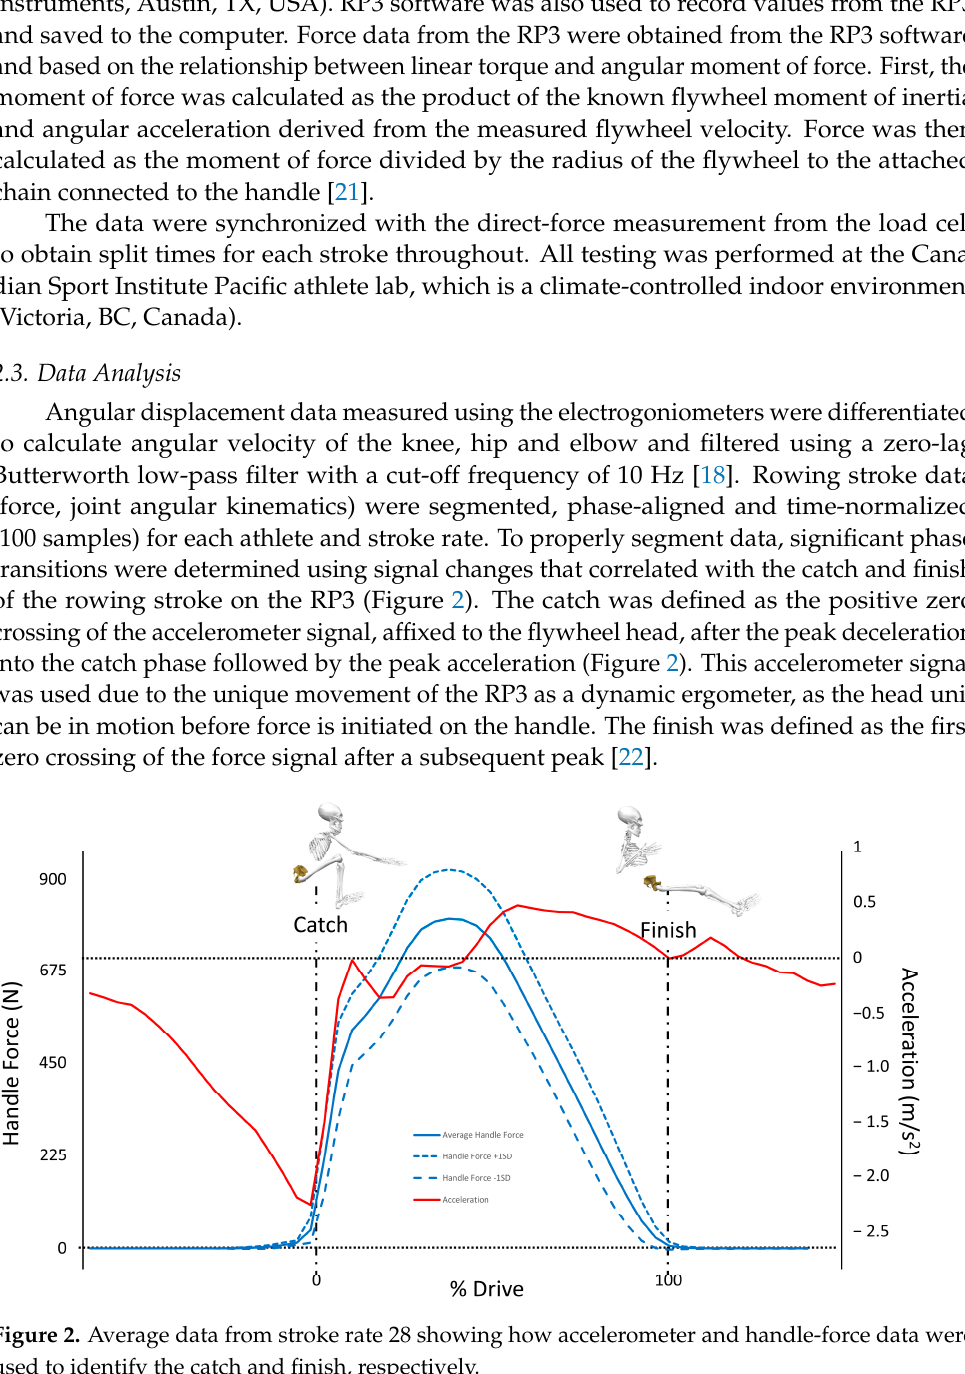
Figure 2. Average data from stroke rate 28 showing how accelerometer and handle-force data were used to identify the catch and finish, used to identify the catch and finish, respectively.